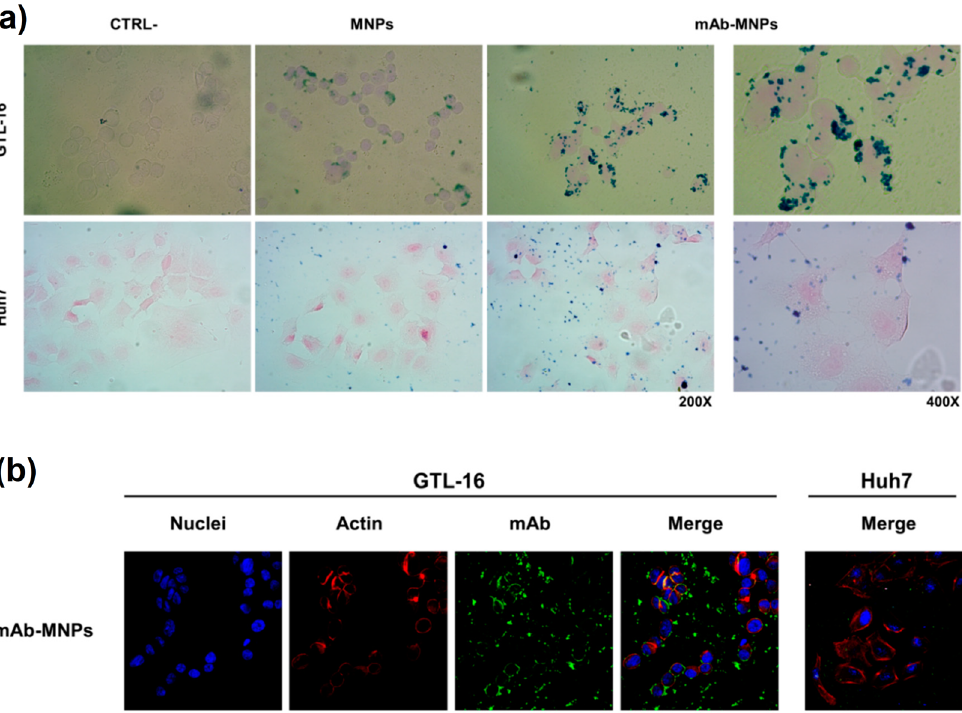
Figure 13. Selective interaction of mAb-functionalized MNPs with GTL-16 cells in comparison with Huh7 cells under ( a ) optical and ( b ) fluorescence confocal scanning microscopy. Adapted from reference [41].